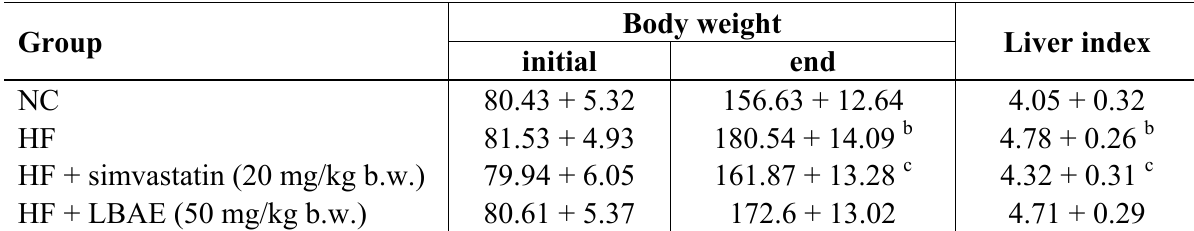
Table 1. Effect of LBAE and LBEE on body weight and liver weight of